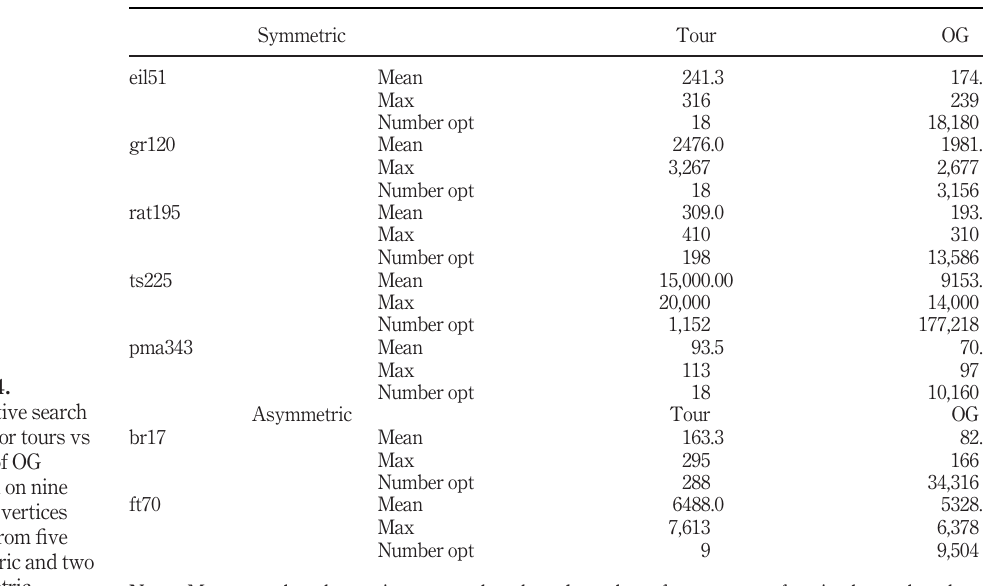
Table 4. Exhaustive search results for tours vs output of OG function on nine random vertices drawn from fi ve symmetric and two